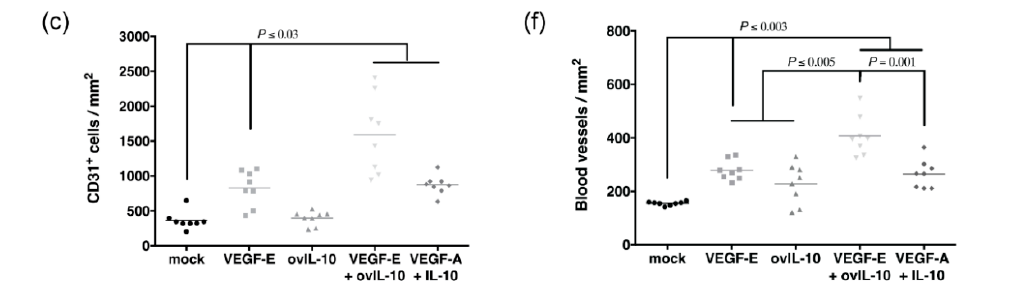
Figure 5. VEGF-E and ovIL-10 synergistically enhance wound re-vascularisation. ( a ) Representative image of a day 6 wound section stained with antibodies to CD31 (green) and α SMA (red) and the nuclear stain DAPI (blue). The wound margin (WM) and granulation tissue (GT) are outlined with a yellow line. Scale bar = 300 µ m. ( b ) Representative images of the WM adjacent to the GT in day 6 wound sections after two SC injections of the indicated treatment. CD31 + ve endothelial cells and α SMA + ve pericytes associated with the vasculature are indicated by green and yellow arrows, respectively. Auto-fluorescent red blood cells are indicated by orange arrows. Scale bar = 50 µ m. ( c ) Number of CD31 + ve endothelial cells per mm 2 in the WM and GT at day 6 post-wounding. Data are presented with each symbol representing an individual wound, and the line indicating the mean of 8 wounds, p values are indicated. ( d ) Representative image of a day 9 wound section stained with antibodies to vWF (green) and α SMA (red) and the nuclear stain DAPI (blue). The WM and GT are outlined with a yellow line. Scale bar = 300 µ m. ( e ) Representative images of the GT near the upper WM in day 9 wound sections after four SC injections of the indicated treatment. vWF + ve endothelial cells, α SMA + ve pericytes and red blood cells are indicated by green, yellow and orange arrows, respectively. Scale bar = 50 µ m. ( f ) Number of α SMA + ve pericyte-covered blood vessels per mm 2 in the WM and GT at day 9 post-wounding. Data are presented with each symbol representing an individual wound, and the line indicating the mean of 8 wounds, p values are